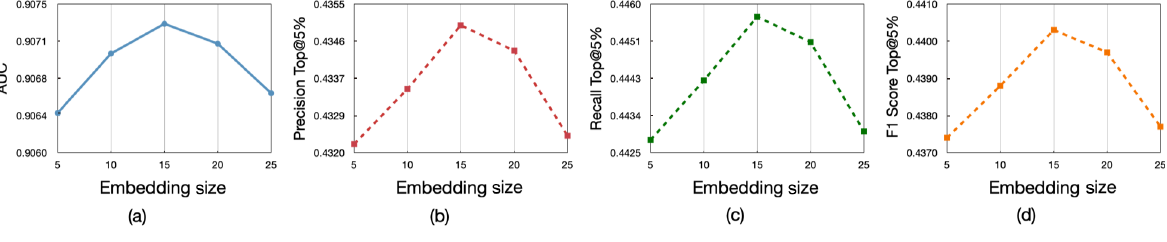
Fig. 4 Performance with respect to the embedding size of SEL.